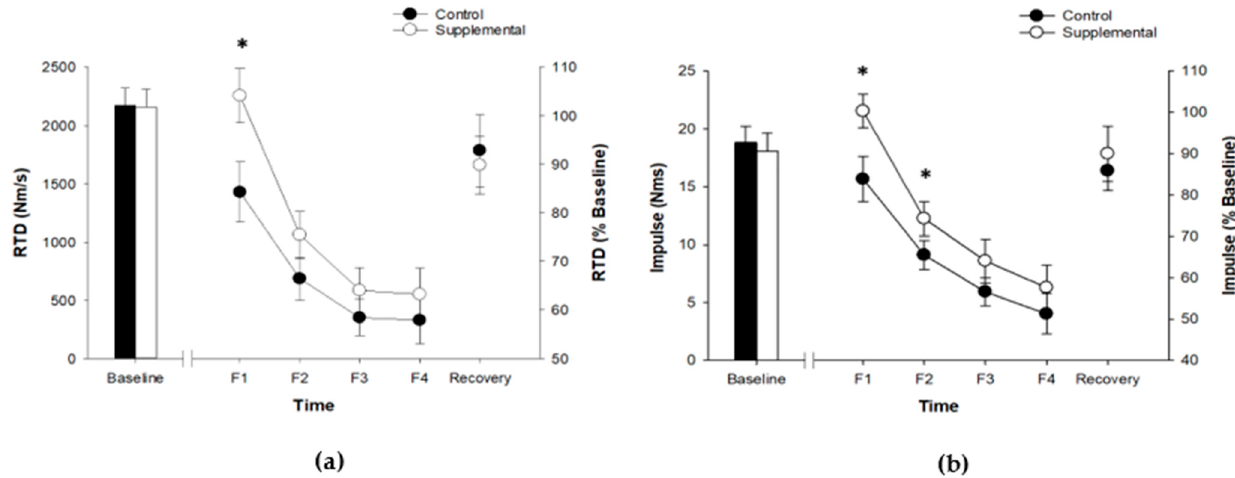
Figure 2. Rate of torque development during first 400 ms of each MVIC ( a ); Impulse during the first 200 ms of each MVIC ( b ). F1–F4 denotes ~10 s time duration when MVIC was performed during and after fatiguing tasks. Values are mean ± SE, presented with both absolute (left axis) and relative (right axis) scales. *—Significant difference between two sessions ( p < 0.05).